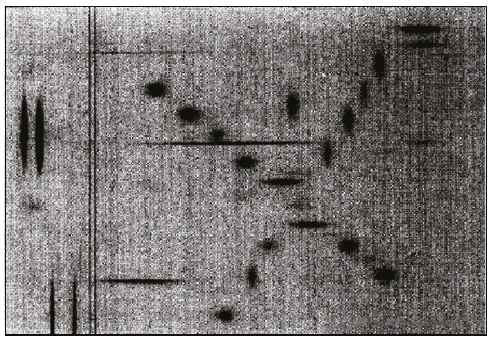
Figure 24: TFD of the example signal. The horizontal axis is time. The vertical axis is frequency. The highest frequencies are on the top. The darkness of this t-f image increases with the value of